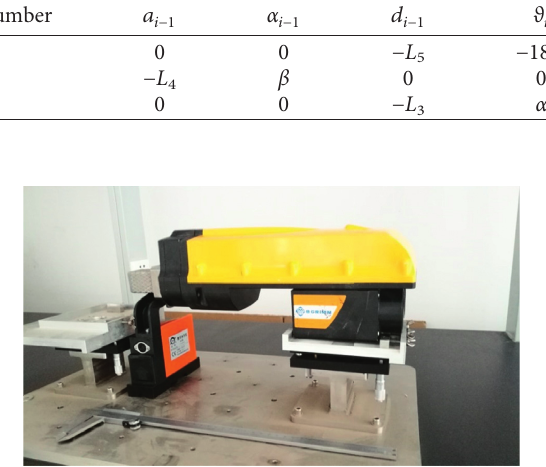
Figure 4: The distance parameter calibration platform of the inner